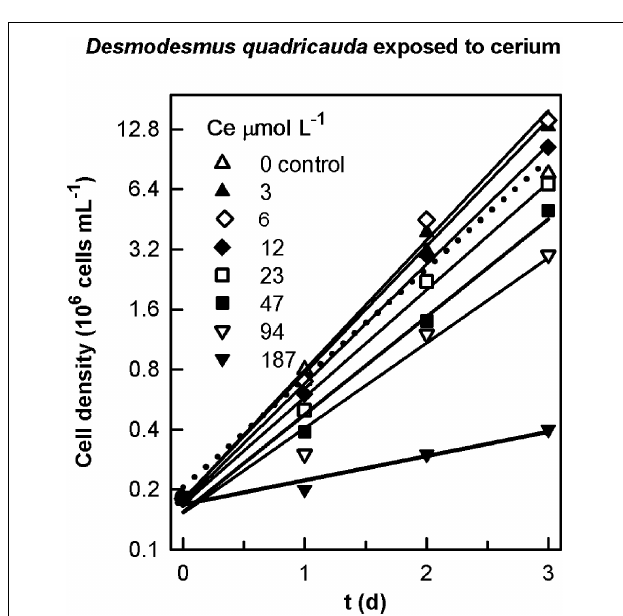
FIGURE 1 | Changes in cell number in cultures of the alga Desmodesmus quadricauda grown in the presence of different concentration of cerium. The suspensions of cultures were grown in a 96-well microplate for 3 days.